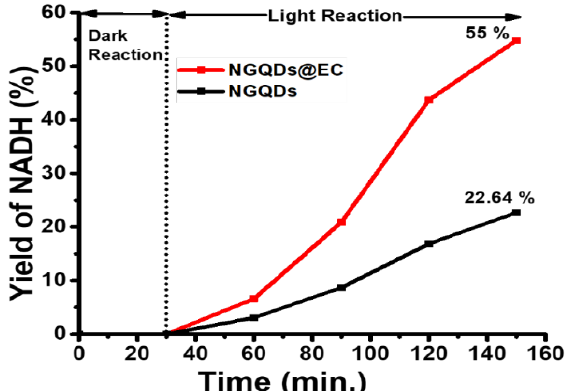
Figure 6. Regeneration of NADH from NGQDs (black line) and NGQDs@EC (red line) photocatalyst